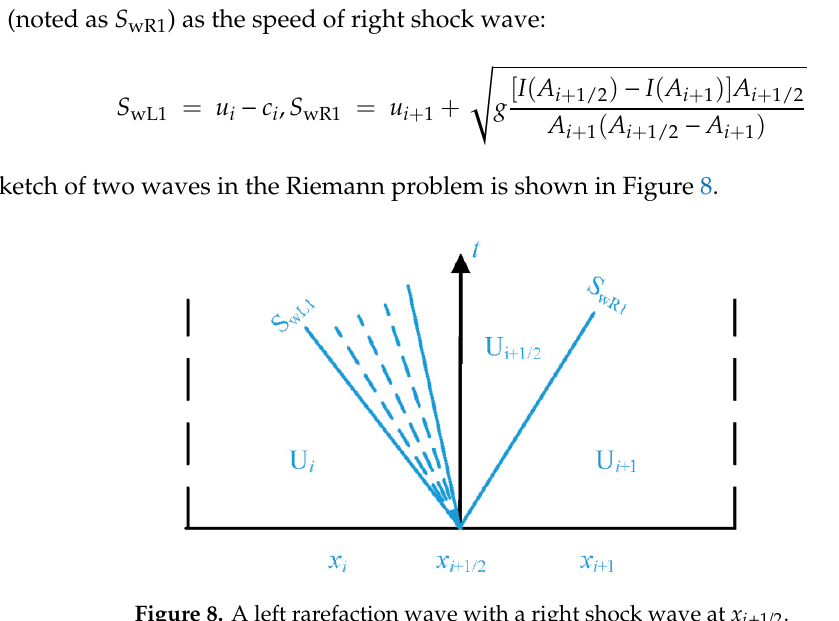
Figure 8. A left rarefaction wave with a right shock wave at x i +1/2 .